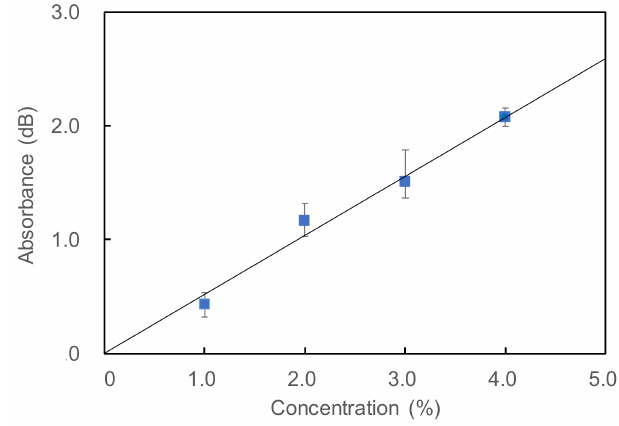
Figure 9. Calibration plot between measured optical absorbance and CO 2